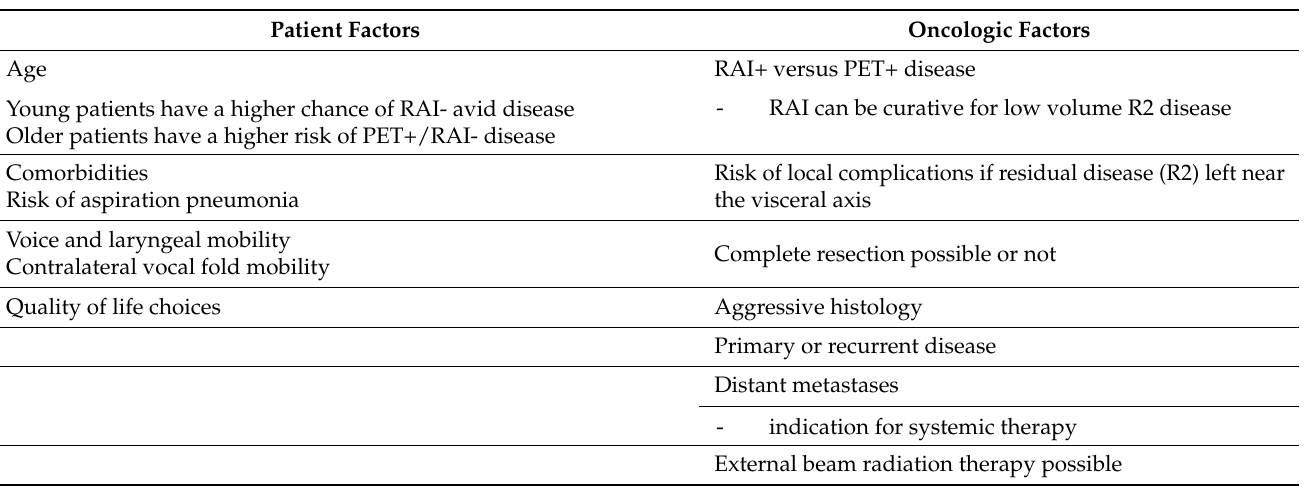
Table 2. Factors to consider when choosing nerve preservation versus nerve resection (adapted from References